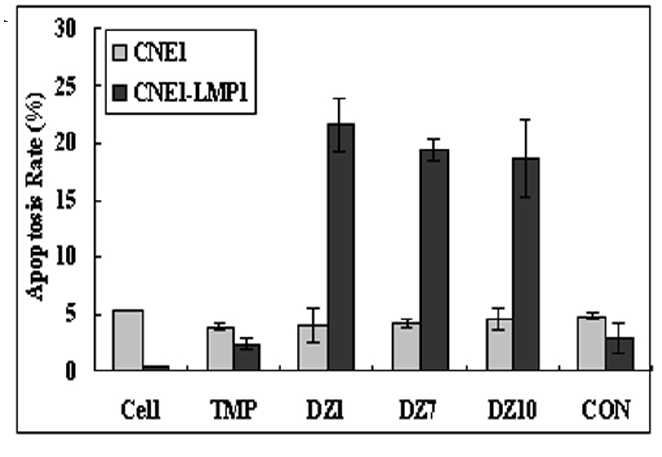
Figure 5. Promotion of apoptosis in LMP1 positive NPC cells by Dz1. Cells were transfected with DNAzymes or controls, The apoptotic rates (sub-G1 population) of CNE1- LMP1 were measured by FACS analyses (values are the means ± SD of three replicates, *p < 0.05 compared with TMP